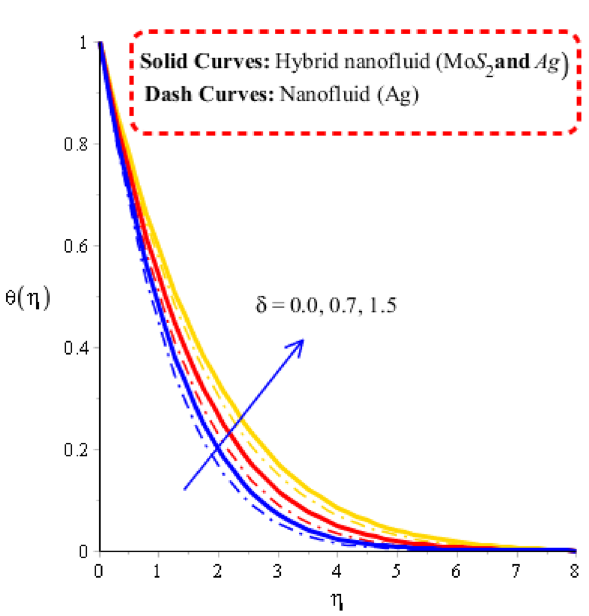
0.3, (cid:31) 0.3, γ 0.3, Fr 1.6, Pr 204, Hs 1.3, ∗ = = = = = = −